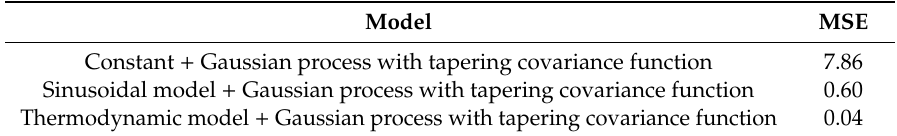
Figure 7. Examples of estimated temperature profiles: ( a ) coordinate (10.5, 20.5, 3.9), ( b ) coordinate (15.5, 5.5, 3.9), ( c ) coordinate (15.5, 40.5, 2.1), ( d ) coordinate (20.5, 25.5, 2.1). (Note: the blue dashed area represents the 95% confidence interval). Table 3. Comparison of model performance using various mean functions.